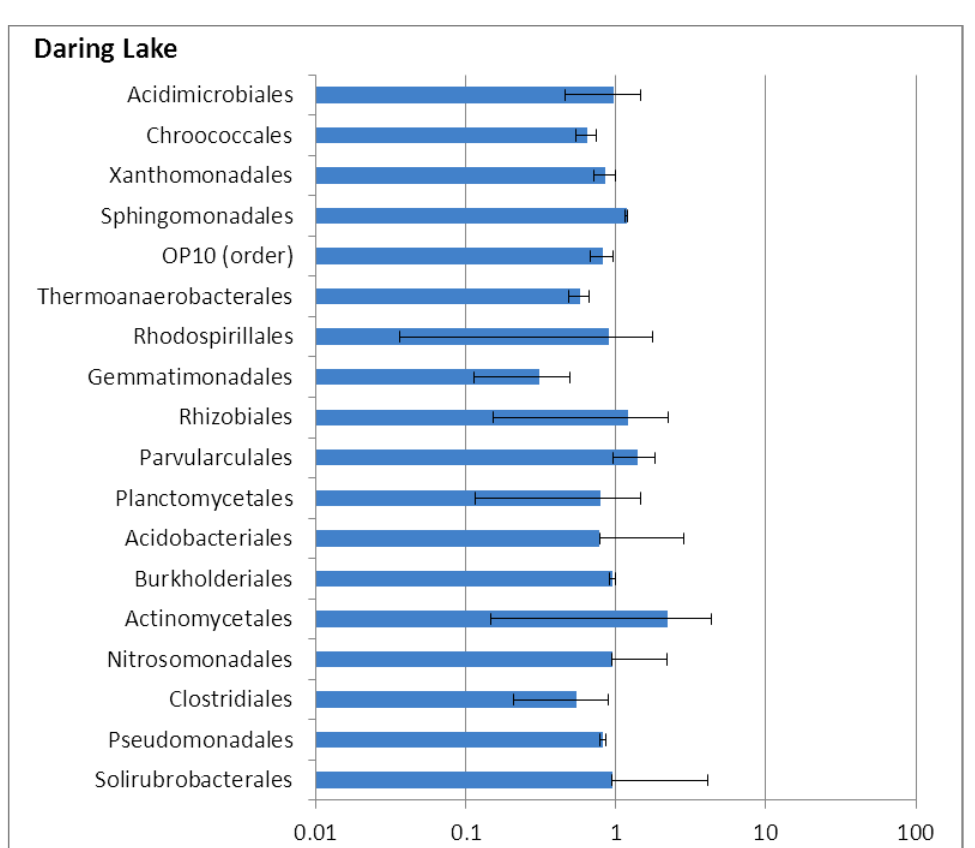
Figure 4. The effect of the freeze-thaw treatment on the relative abundance of each of the bacterial Orders (with those with (cid:149) 1% abundance for either treatment or control groups shown) in the soils from Daring Lake, Cambridge Bay and Alexandra Fjord. Data are ratios of the mean abundance before and after freeze-thaw treatment, with no change in the mean abundance in the Order after treatment indicated by 1. Increases and decreases relative to control values are shown as bars with mean values >1 or <1, respectively. Standard errors of the means are shown as lines on the bars. Sequences were obtained in triplicate for all controls and treatment samples. However, caution must be used in examining the FTC-treated Alexandra Fjord microcosms since one of the isolated DNA samples could not be optimally pyrosequenced; only operational taxonomic units representing the most abundant orders were reported in one of the three replicates and, therefore, this particular file set was not considered in the